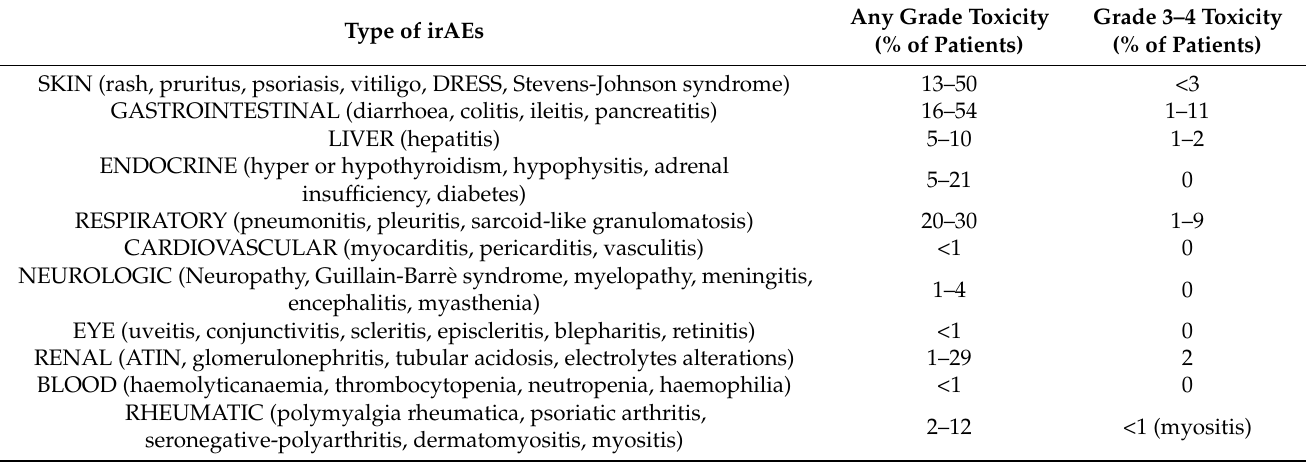
Table 1. Summary of the immune-related adverse events (irAEs) linked to the use of ICIs. Type of